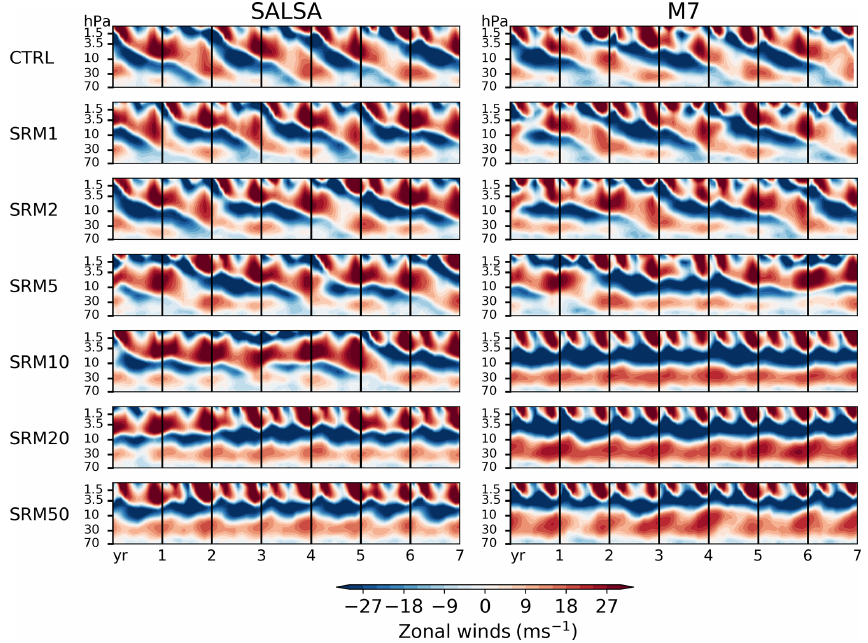
Figure 12. Zonal mean zonal wind (ms − 1 ) at the Equator for the CTRL simulation and stratospheric sulfur injection with different injection rates. The SALSA results are shown in the left panels, and the M7 results are shown in the right